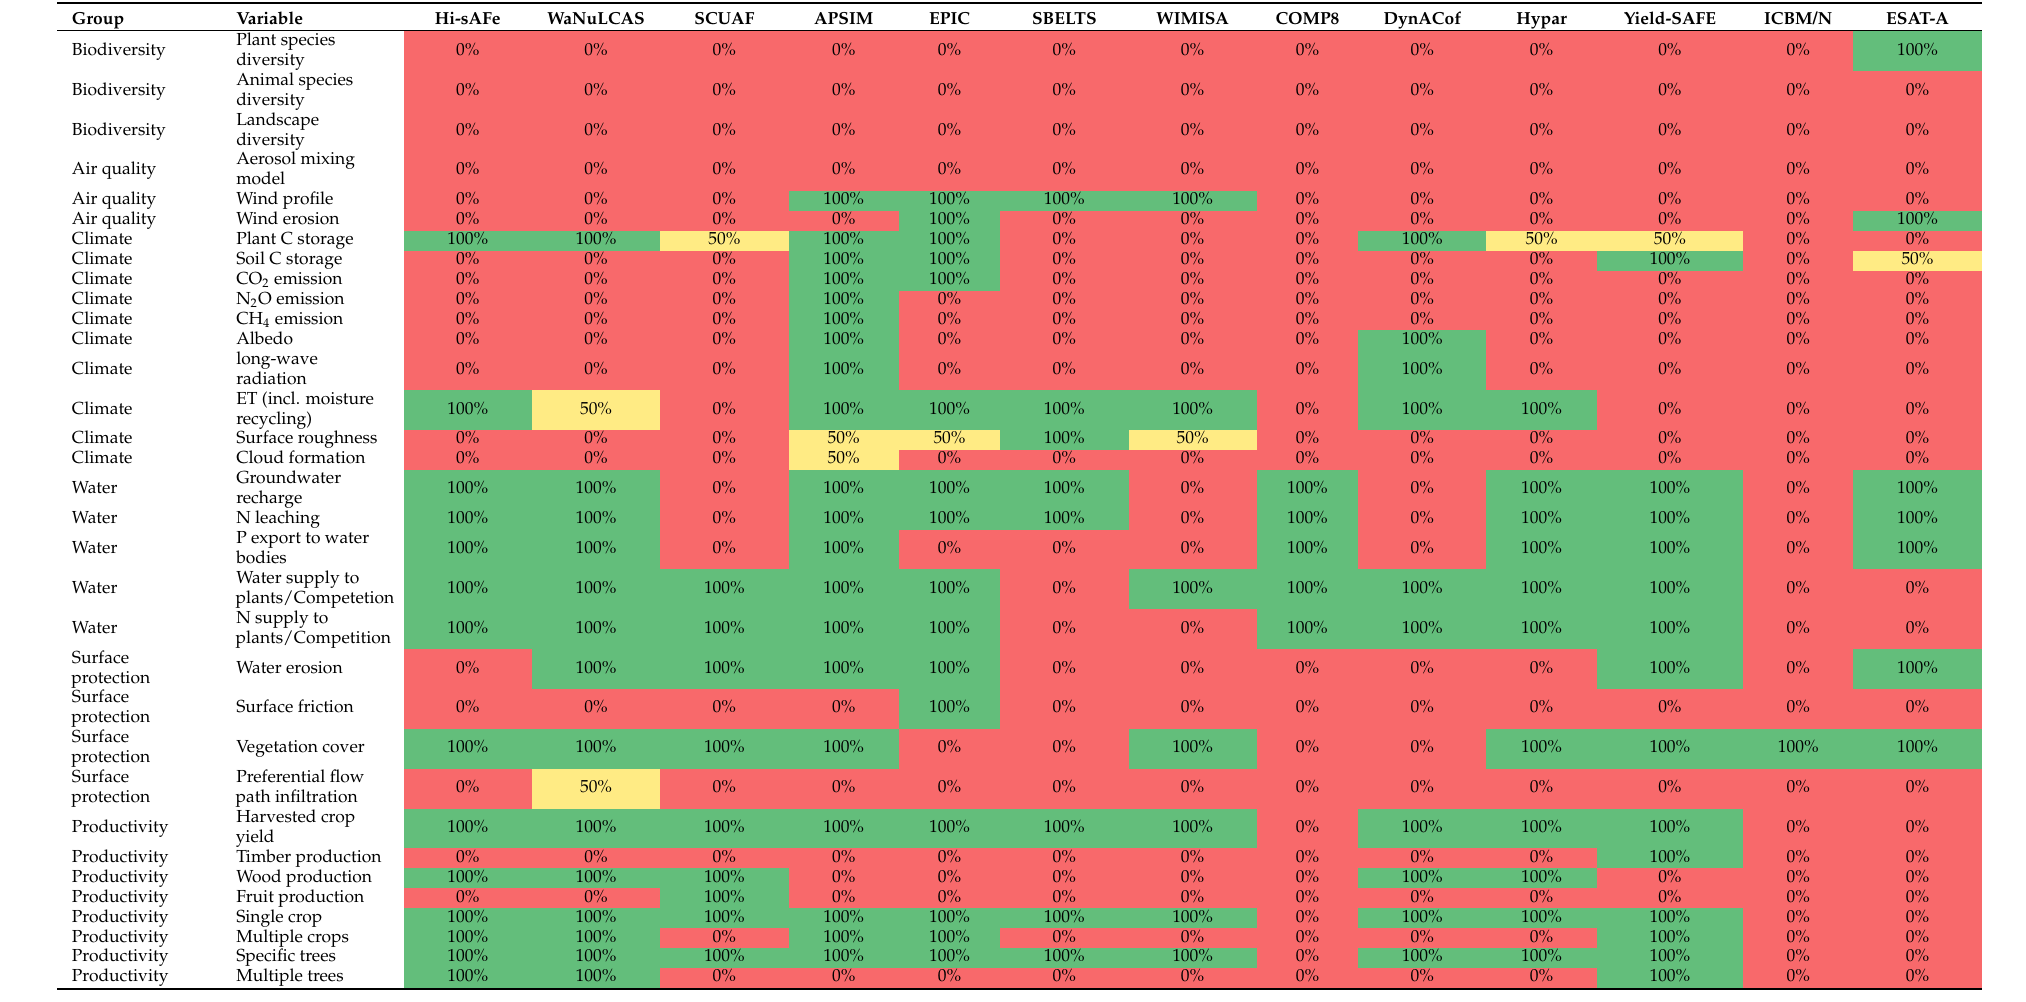
Table A1. Agroforestry’s ecosystem properties, assessed by the existing models. This table is the basis for Table 2. The symbols represent values for averaging. Legend: green: covered by model (1), amber: partly or overly simplistic coverage (0.5), red: ecosystem property not covered by model